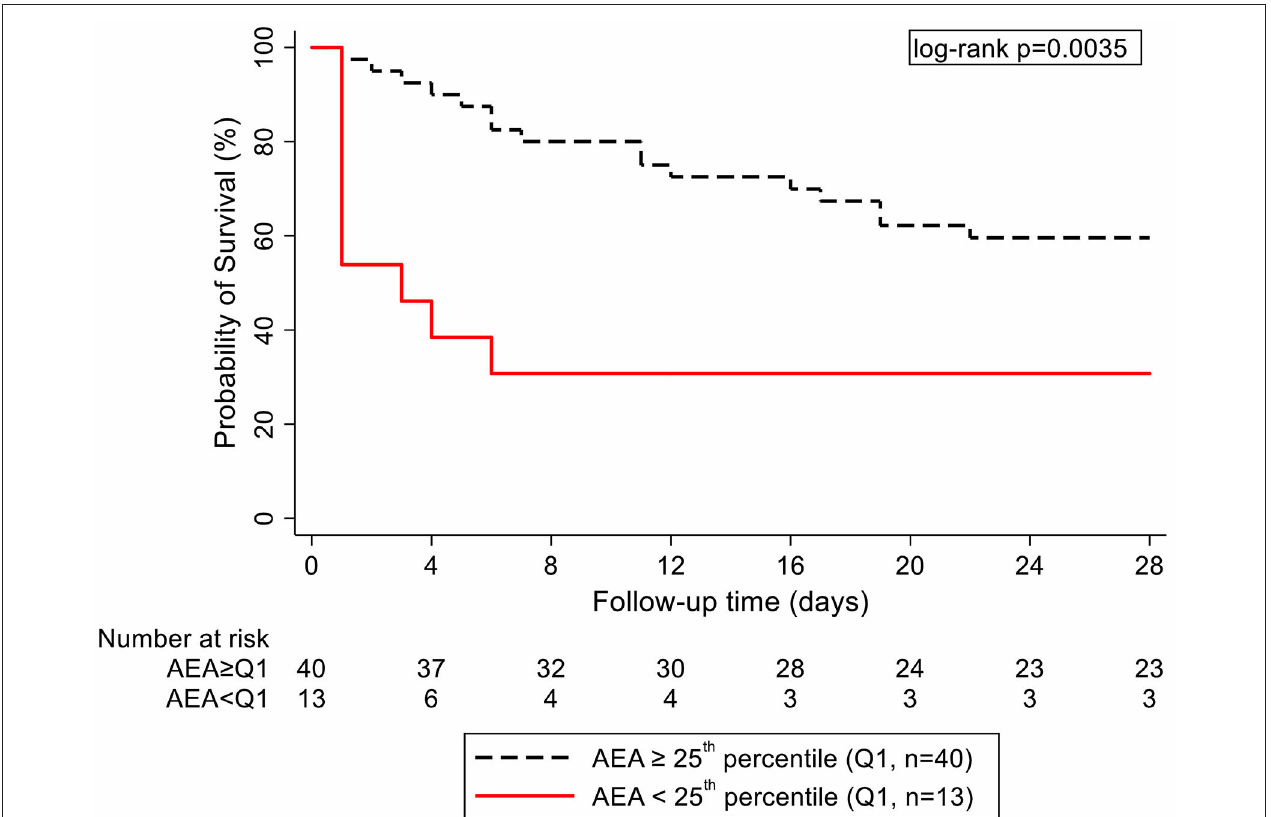
FIGURE 2 | Kaplan–Meier curves of critically ill sepsis patients in dependence of arylesterase activity [empirical cutoff at the 25th percentile of its distribution: lowest quartile (red curve) vs. higher quartiles (dashed black curve)]. AEA, arylesterase activity.